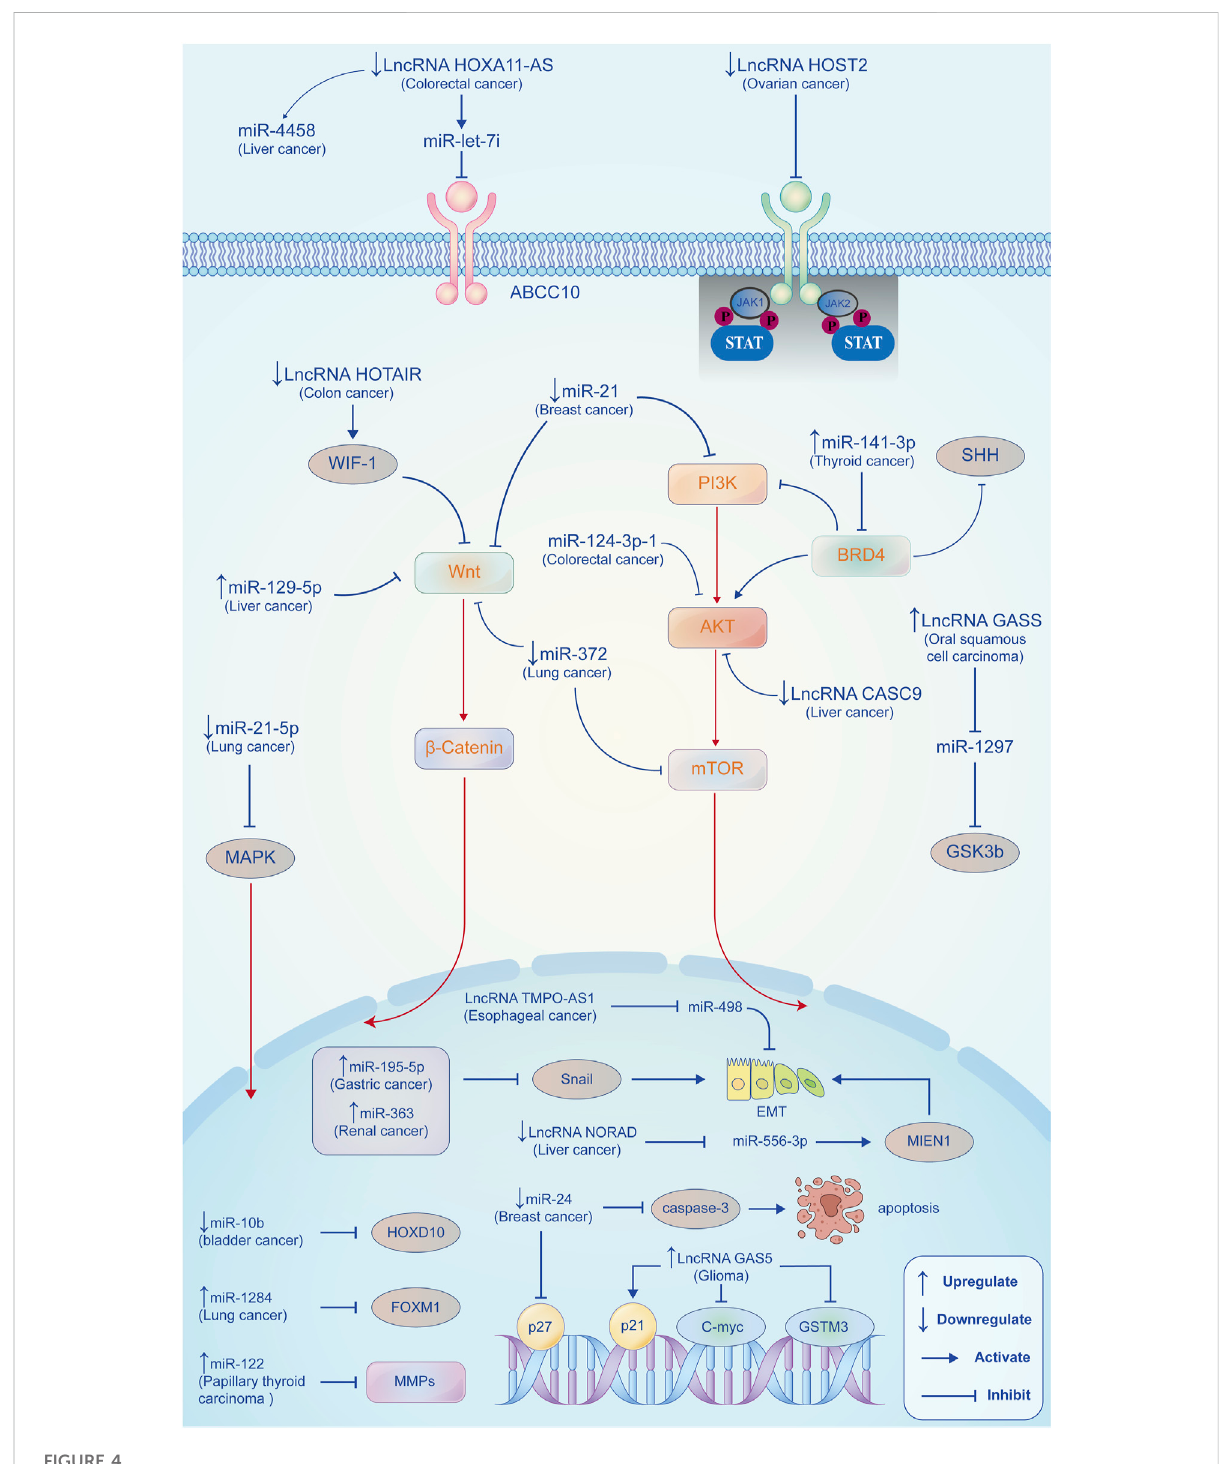
FIGURE 4 Propofolexertsanti-tumoreffectsbyregulatingmiRNAs/lncRNAs.Indifferenttumortypes,propofolregulatestheexpressionofmiRNAs(proto and anti-oncogenes) and lncRNAs to regulate different tumorigenesis and development-related signaling pathways, genes, and proteins expressions,suchasPI3K/AKT,Wnt/ β -catenin,MMPs,P27,andP21,thusinhibitingtheproliferation,invasion,andmetastasisoftumorcells,reducing EMT process and promoting